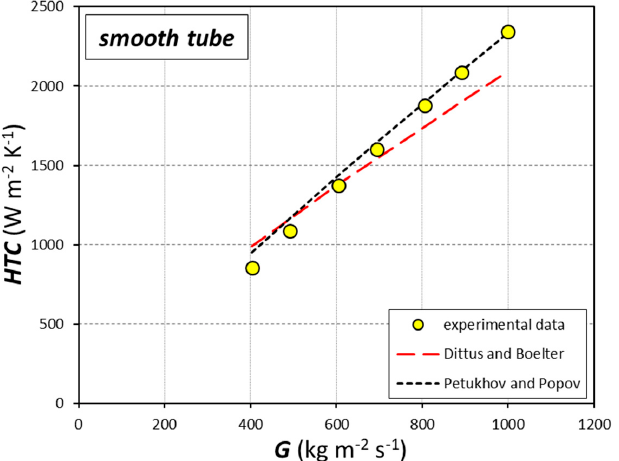
Figure 3. Single-phase heat transfer coefficient for the smooth tube vs. mass velocity.